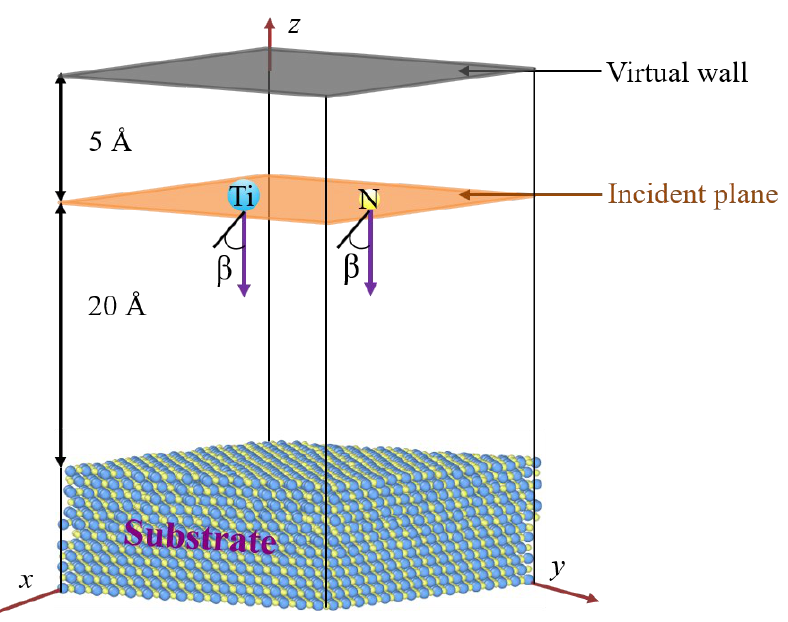
Figure 1. MD simulation box for TiN film deposition.